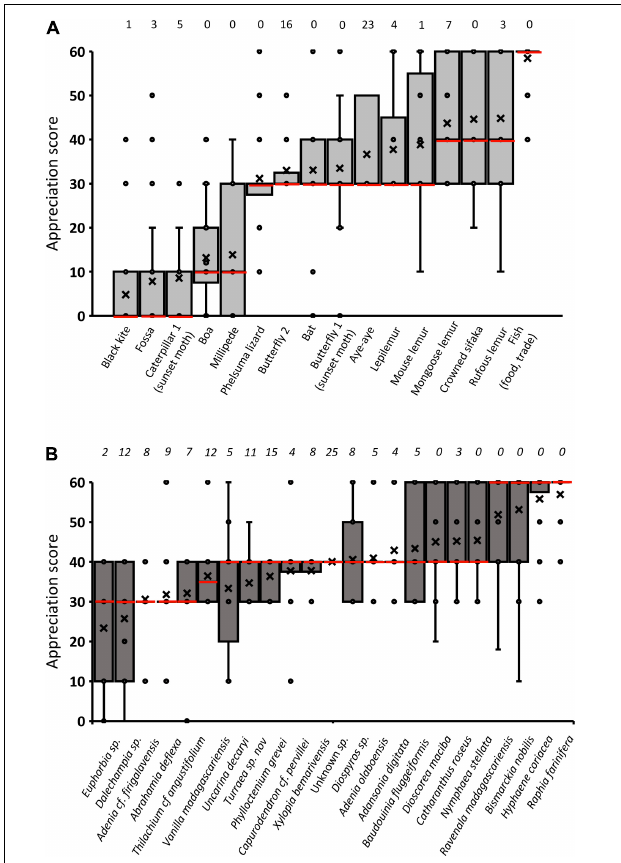
FIGURE 4 | Box plots of the appreciation score for a set of animals (A) and plants (B) , assessed using a 7-point labeled scale. The scores vary between 0 (least appreciated, or that one may wish to disappear) and 60 (the most desired), with an intermediate label (30) attributed to insignificant animals or plants. The median is indicated as a red horizontal bar in each box. Other horizontal bars delineate the 25 and 75% quartiles. Means are represented by a cross and outliers by dots. Figures above bars indicate the number of persons in the sample for whom the tested animal or plant is